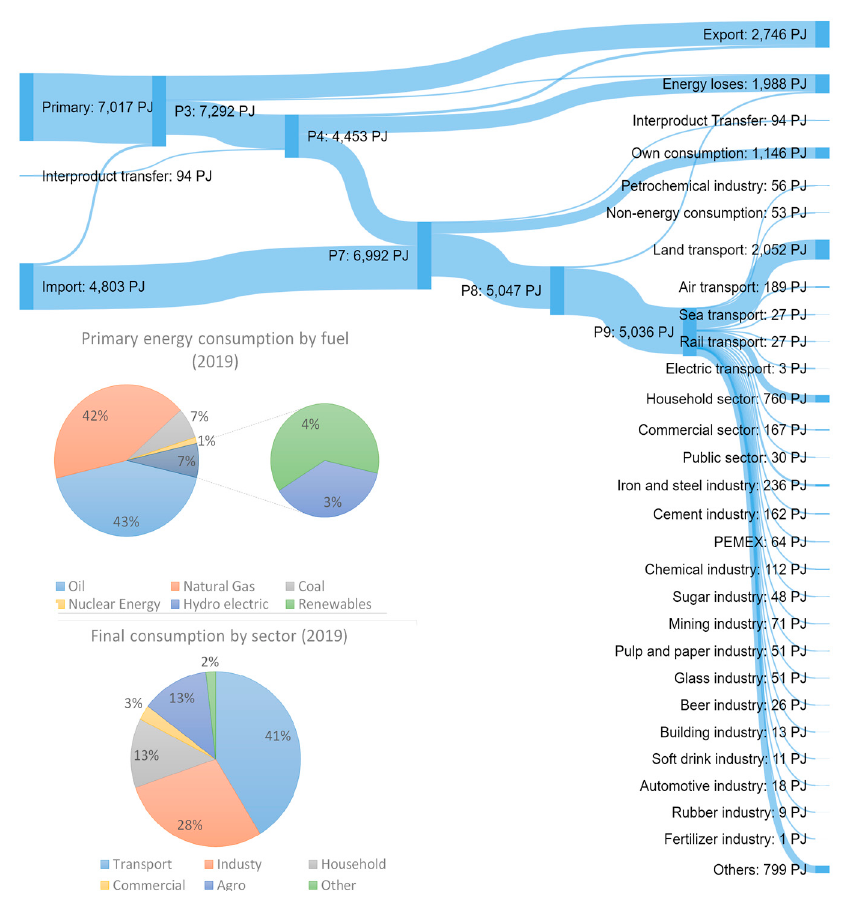
Figure 1. Mexico’s energy flow and final consumption (2019). Source: Adapted by the authors using SENER data [40,42].